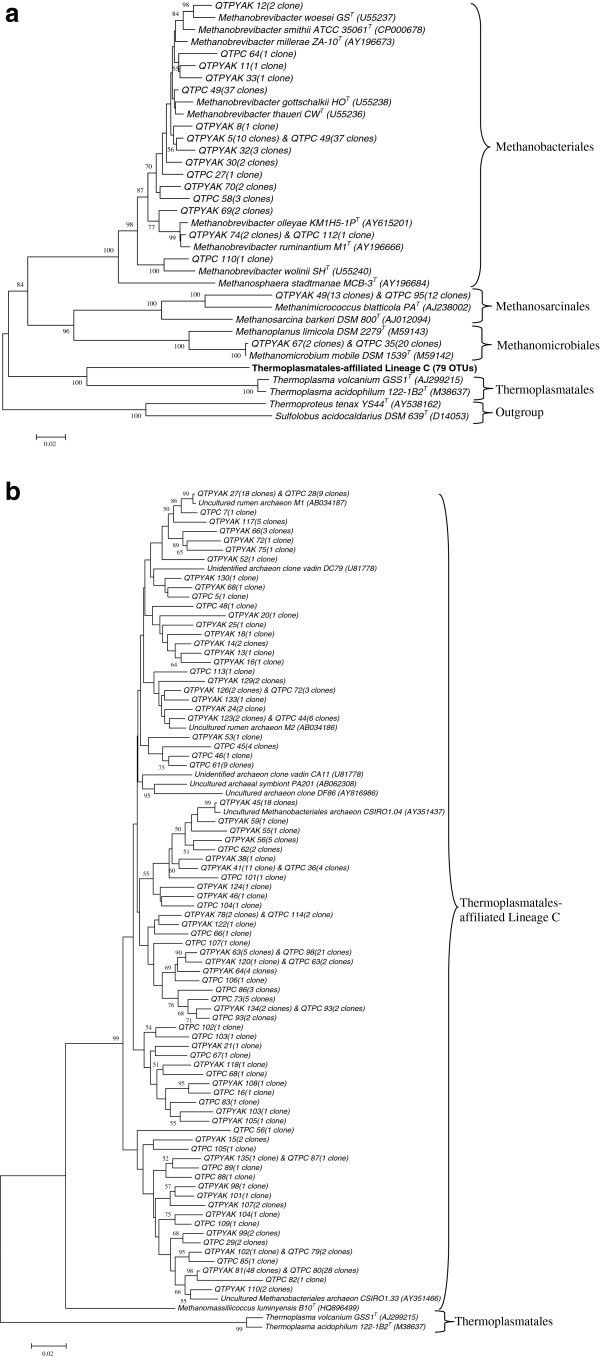
Phylogenetic analysis of methanogen partial 16S rRNA sequences from yak and cattle clone library inferred using MEGA (ver. 5). Of the 414 clones examined, 209 clones from yak and 205 clones from cattle were assigned to 95 OTUs by MOTHUR using a 98% species level identity. These 95 OTUs are shown by representative sequences on the tree. In which, 16 OTUs from non-TALC group are presented in Figure
1a, and 79 OTUs from TALC group are presented in Figure
1b. GenBank accession number are indicated in parentheses and bootstrap values (>50%) from 1000 replications are indicated on the tree.The scale bar corresponds to 2 changes per 100 positions.